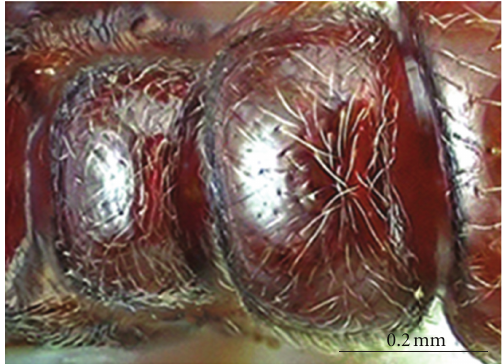
Figure 6: Tatuidris kapasi , holotype worker. Detail of petiole and postpetiole, dorsal